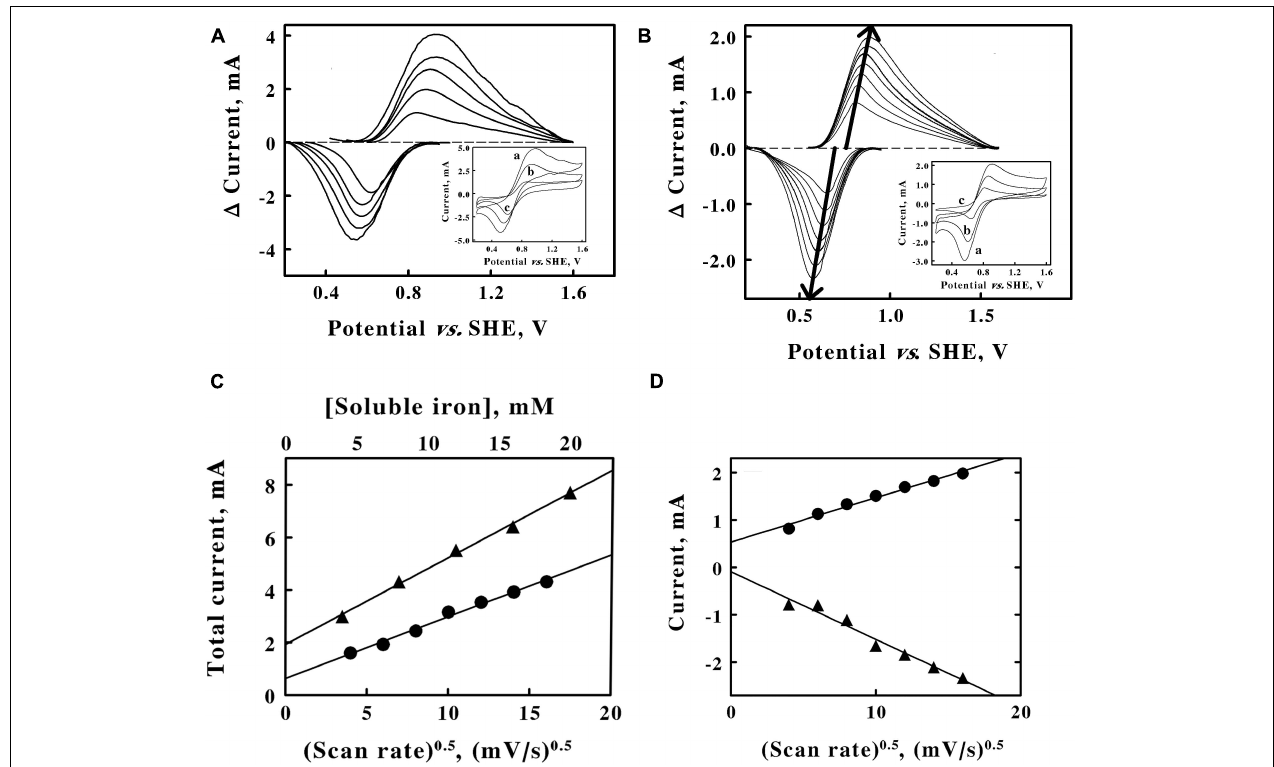
FIGURE 2 | Cyclic voltammetry on soluble iron in sulfuric acid, pH 1.5. A , baseline-subtracted anodic ( positive ) and cathodic ( negative ) peak currents obtained with a scan rate of 256 mV/s at 5 concentrations of ferrous sulfate: 4, 8, 12, 16, and 20 mM, from lower to higher magnitude currents, respectively. Inset , representative cyclic voltammograms obtained with 20, 12, and 4 mM ferrous sulfate for curves a , b , and c , respectively. Each of the five cyclic voltammograms in panel A represents the mean of four highly reproducible individual measurements whose values varied by less than 1% among the four measurements. (B) Baseline-subtracted anodic ( positive ) and cathodic ( negative ) peak currents obtained with 8 mM ferrous sulfate at 7 scan rates: 16, 36, 64, 100, 144, 196, and 256 mV/s, from lower to higher magnitude currents, respectively. Each bold arrow passes through the peak of the current associated with each curve . Inset , representative cyclic voltammograms obtained at scan rates of 256, 100, and 16 mV/s for curves a , b , and c , respectively. Each of the seven cyclic voltammograms in panel B represents the mean of four highly reproducible individual measurements whose values varied by less than 1% among the four measurements. (C) , secondary plots of the total peak currents as a function of the soluble iron concentration ( triangles, upper abscissa ) and the square root of the scan rate ( circles, lower abscissa ) using data extracted from panels A,B , respectively. (D) , values for the anodic ( circles ) and cathodic ( triangles ) currents as a function of the square root of the scan rate. Each datum in panels C,D represents the mean of four determinations. In all cases, the standard deviation of each datum was within the area bound by the diameter of the datum in the